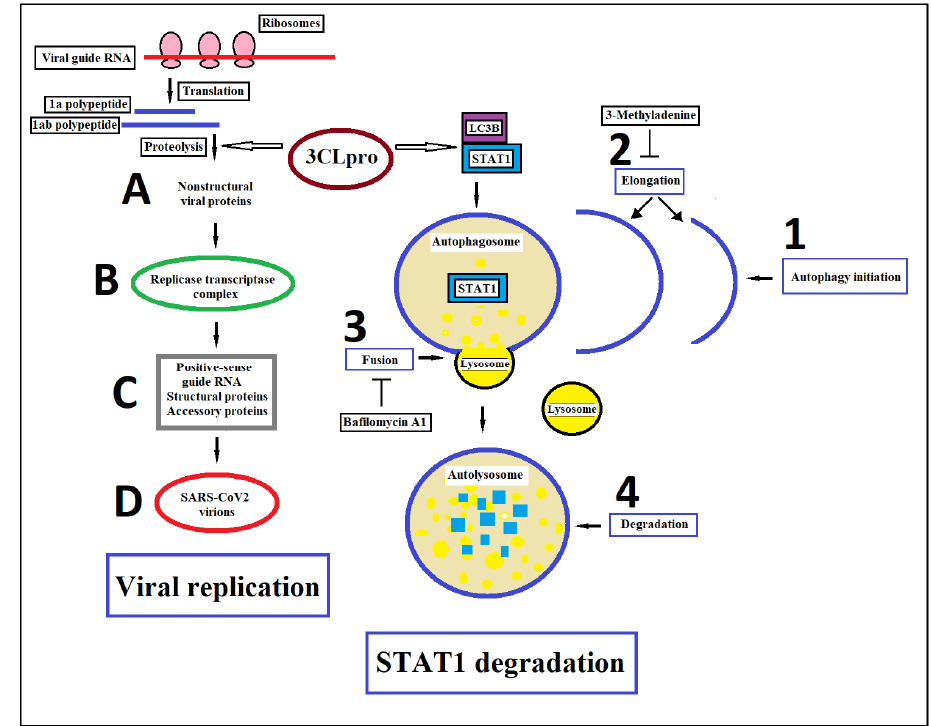
Figure 4. Schematic representation of 3CLpro effects in viral replication and STAT1 degradation. SARS-CoV-2 is a positive-sense single-stranded RNA virus. Upon fusion of the viral and host cell membranes, viral genomic RNA is released in the cytoplasm. (A) the viral RNA initiates the translation of co-terminal polypeptides 1a and 1ab. These polyproteins are subsequently cleaved by 3CLpro protease into non-structural proteins such as RNA-dependent RNA polymerase, helicase and ribonucleases; (B) the coronavirus replicase-transcriptase complex is an assembly of viral and cellular proteins that mediates the synthesis of genome- and subgenome-sized mRNAs in the virus-infected cell; (C) in the course of the SARS-CoV-2 infective cycle, the replicase-transcriptase complex amplifies the genomic RNA and synthesizes mRNAs that encode the structural proteins of the virus and proteins that are non-essential for replication in cell culture but appear to confer a selective advantage in vivo (accessory proteins); (D) production of new virions. The autophagic process is divided into four distinct stages: (1) Initiation, (2) autophagosomal formation (elongation), (3) autophagosome-lysosome fusion, and (4) autophagolysosome formation and cargo degradation. LC3B is a central protein in the autophagy pathway, where it functions in autophagy substrate selection and autophagosome biogenesis. 3CLpro could promote the colocalization between STAT1 and LC3B causing the autophagic degradation of STAT1, as shown by the rescue of STAT1 by autophagy/autolysosome inhibitor 3-methyladenine and bafilomycin A1.